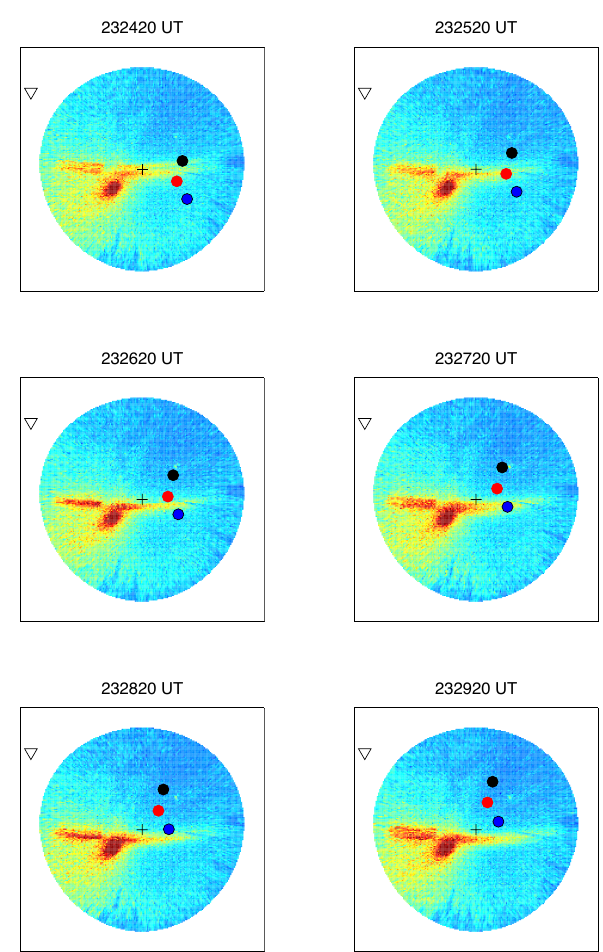
Fig. 2. Ground projection of the three operative Cluster s/c mapped according to T89c model, K p =3 and the equatorward auroral arc measured by the SOD all-sky camera at 557.7nm. Color coding for intensity (in arbitrary units) is used and the field of view of 140 ◦ at an altitude of 100km is shown. The moon is visible in the direction of the arc and the triangle shows the location of